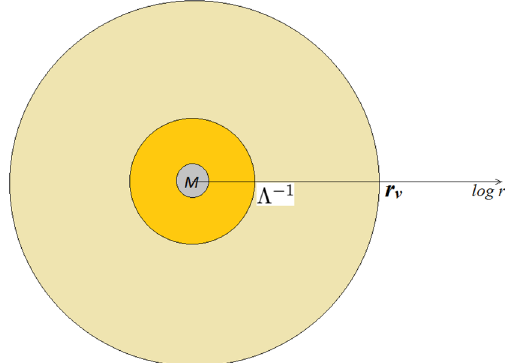
Fig. 16 Overall picture of the Vainshtein screening mechanism. There are three regions of interest: ( r (cid:10) r v ) far outside the Vainshtein radius and away from the source, the fifth force is not screened; ( r (cid:18) r v ) near the source and below r v , the fifth force is suppressed (this includes Λ − 1 (cid:18) r (cid:18) r v ). r = Λ − 1 represent the cut-off scale of the theory and is typically very large compared to the Schwarzschild